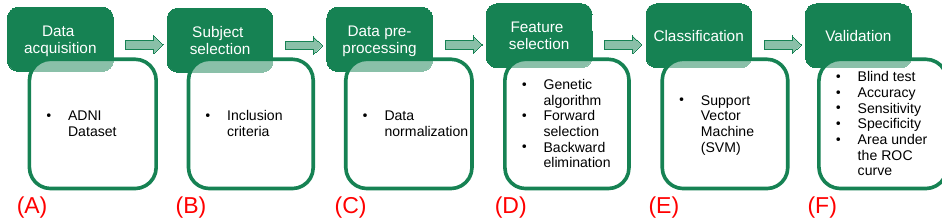
Figure 1. Flowchart of the proposed methodology. The green squares refer to the data processing methodology, while the white squares detail the task involved in each step. ( A ) The different datasets (gene indexes and clinical and neuropsychological assessments) are obtained from the ADNI database. ( B ) Each dataset is analyzed and new data sets are created by selecting subjects according to the criteria described in Table 2. ( C ) A preprocessing of the data is applied: handle the empty fields and perform data transformations. ( D ) The use of genetic algorithms is implemented to extract the main data features. ( E ) Using the main features for Alzheimer’s detection in patients, several models are generated using the support vector machines. ( F ) The validation of our results is carried out using different metrics (accuracy, sensitivity, specificity and AUC) to determine which of the models has the best